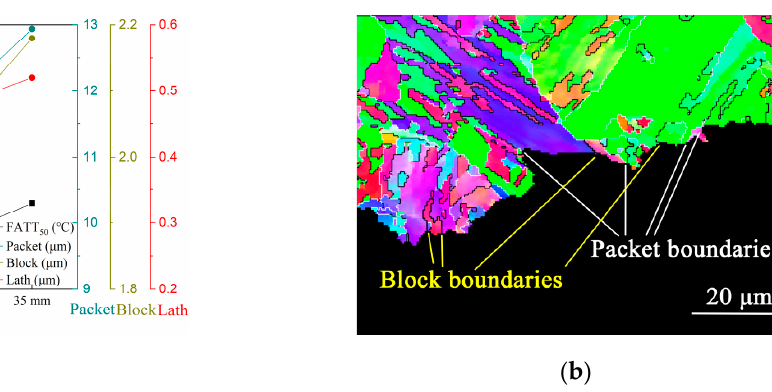
Figure 11. ( a ) Correlation between substructures size and toughness, and ( b ) IPF map selected from the impact sample profile shows an effect of the substructures’ boundary on the crack propagation.